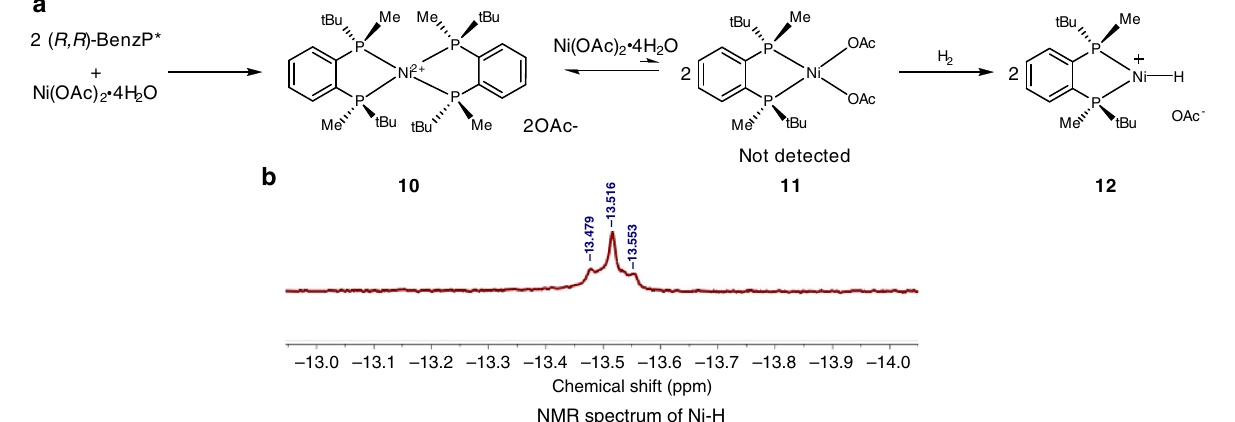
Fig. 3 The experimental studies of coordination and Ni-H species. a Formation of the catalyst 12 . b 1 H NMR Spectrum of Ni −